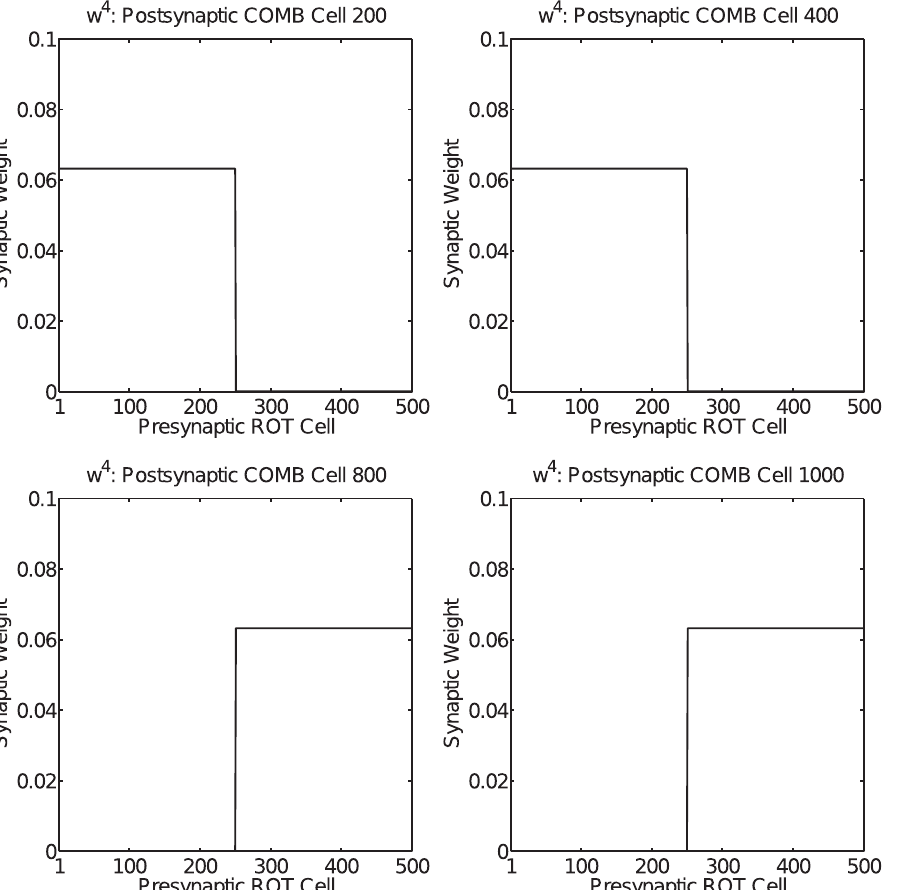
Figure 6. The synaptic weights w 4 from the layer of Rotational Velocity (ROT) cells to the Combination (COMB) cell network after learning with the Hebbian associative learning rule (12) and weight normalization (13). These results are from a simulation with an axonal conduction delay of 100 ms, and a rotational velocity during training of 180 0 = sec (all other parameters are as given in Table 1). Each of the four plots shows the learned synaptic weights to a different postsynaptic COMB cell from the 500 presynaptic ROT cells. As the firing profile of the presynaptic ROT cells is binary, the w 4 synaptic weight profiles in the plots above can be described as a step function of the presynaptic ROT cell firing rate.